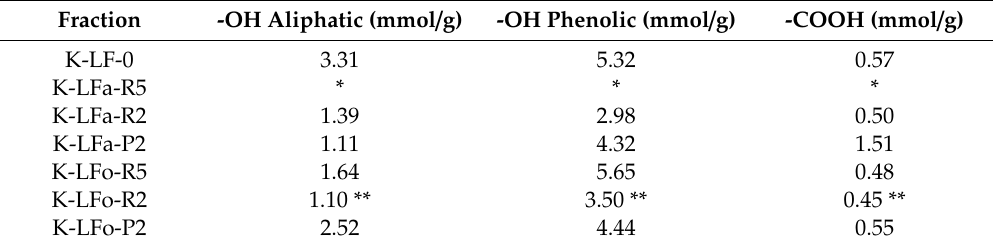
Table 8. Detailed hydroxyl / carboxyl quantification by 31 P-NMR for the fractions recovered from aqueous and organic processes applied on